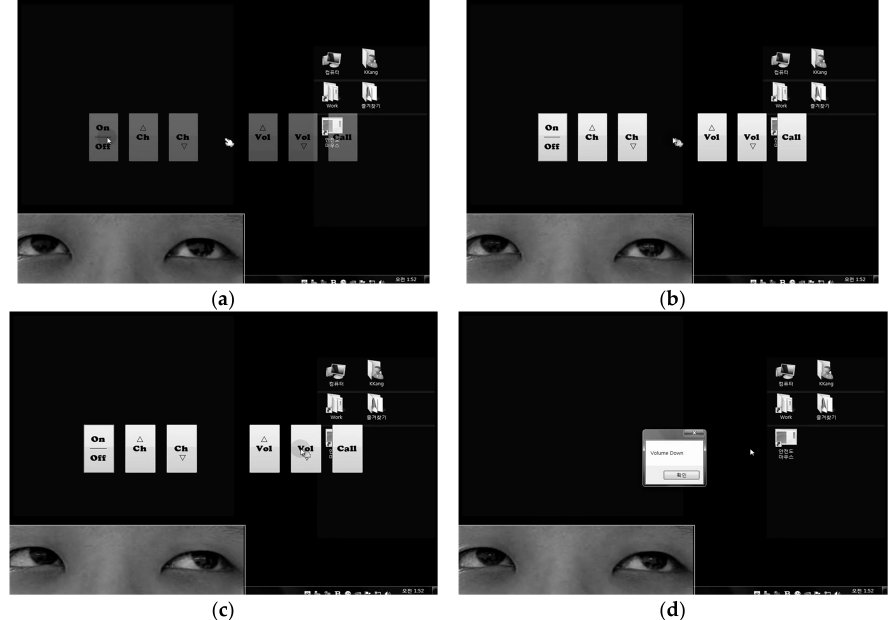
Figure 15. Temporalis EMG signal processing procedure for detection of temporal muscle movement.